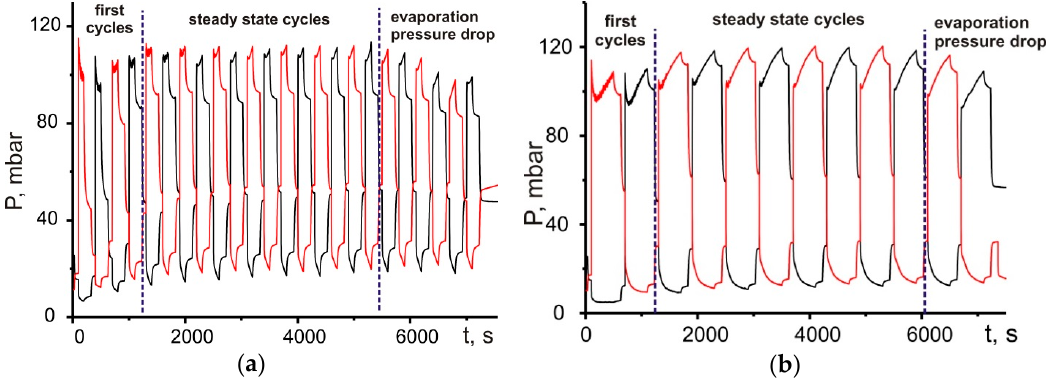
Figure 4. Temporal evolution of methanol pressure in adsorbers A1 (red) and A2 (black). The durations of the adsorption–desorption stages are 100 s ( a ) and 400 s ( b ).